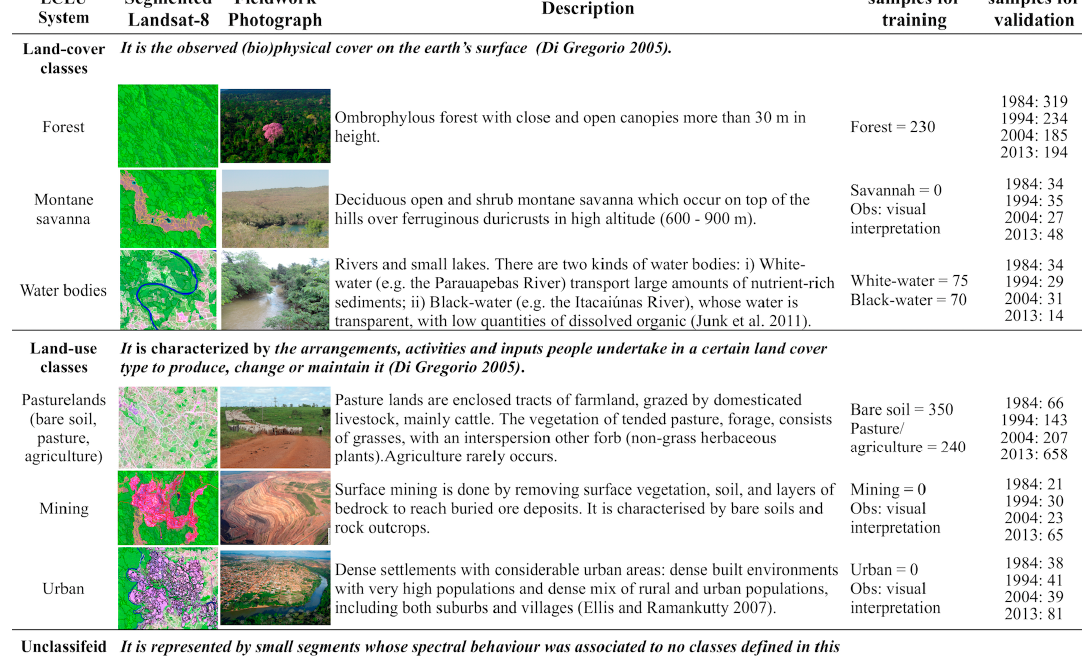
Figure 2. Description of land-cover and land-use classification system in this study.